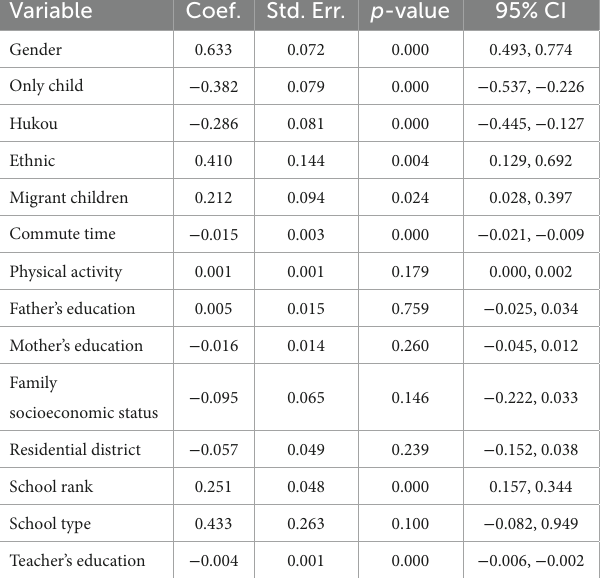
TABLE 3 Propensity score (cycling to school vs.